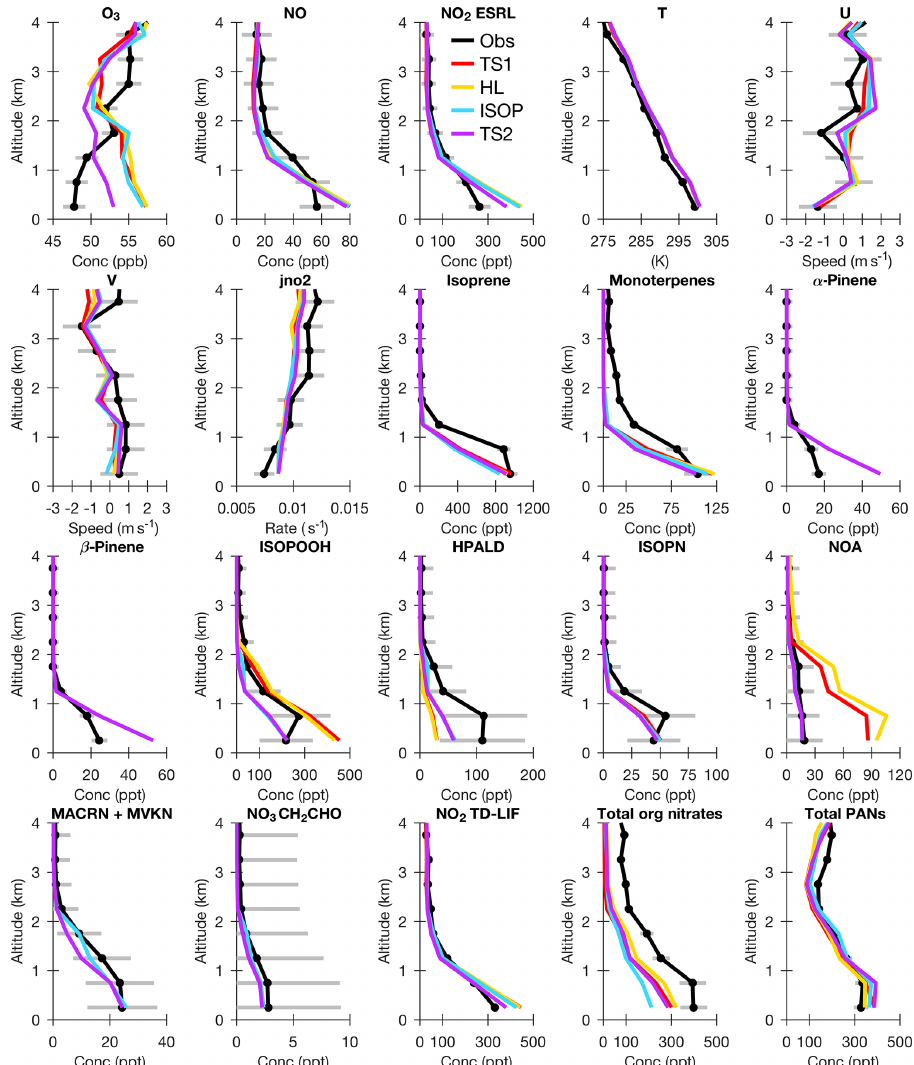
Figure 9. Median vertical profile plots over the SEAC 4 RS flight tracks for observations (Obs – black), TS1 (red), TS2 with only Henry’s law updates (HL – gold), TS2 with Henry’s law and isoprene updates (ISOP – blue), and TS2 with Henry’s law, isoprene and terpene updates (TS2 – purple). Acronyms are defined in Fig. 3. Data are grouped into 0.5km bins and exclude urban plumes (NO 2 > 4ppb), fire plumes (acetonitrile > 0.2ppb), and stratospheric air (O 3 / CO > 1 . 25) as done in previous work (Travis et al., 2016). Domain includes the southeastern US (29.5–40 ◦ N, 75–94.5 ◦ W), and local sun time 09:00 to 17:00. Observational uncertainty is shown in gray